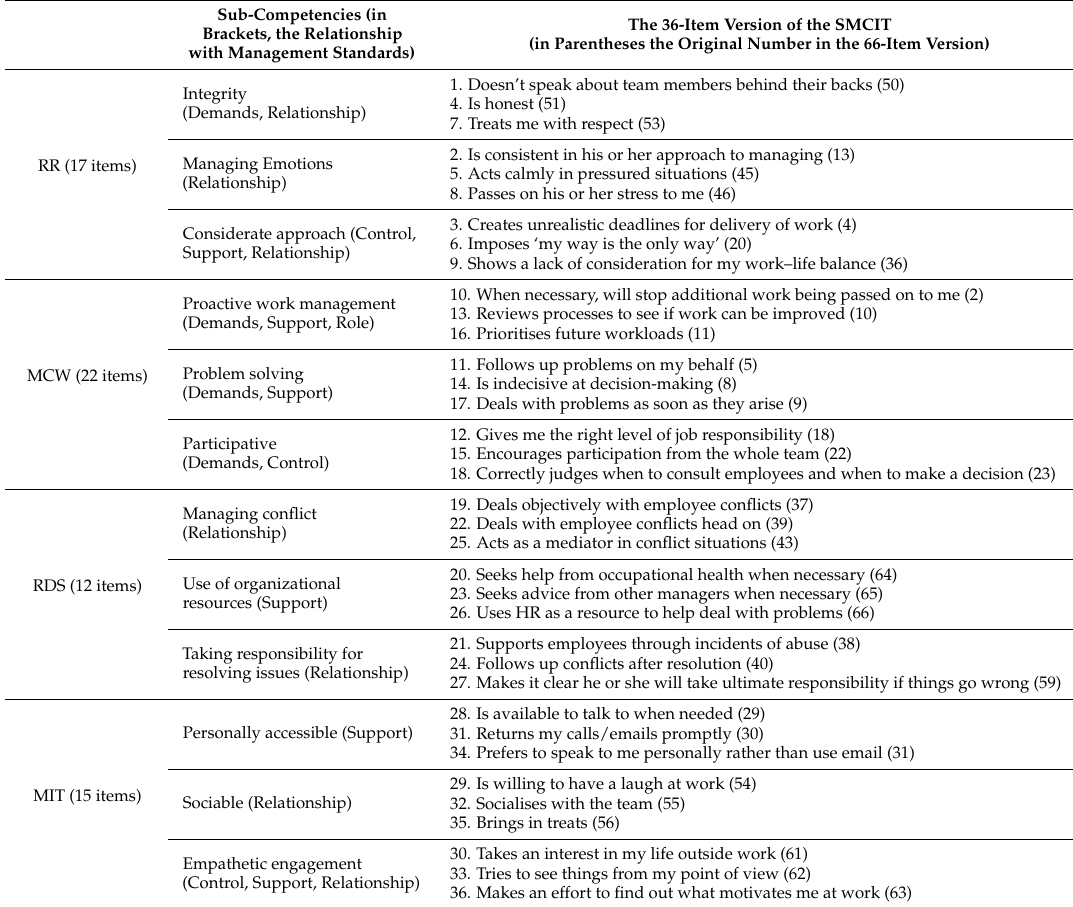
Framework of the “Stress Management Competency Indicator Tool” (SMCIT) and hypothesized relations with the Management Standards and 36-item version. Sub-Competencies (in Brackets, the